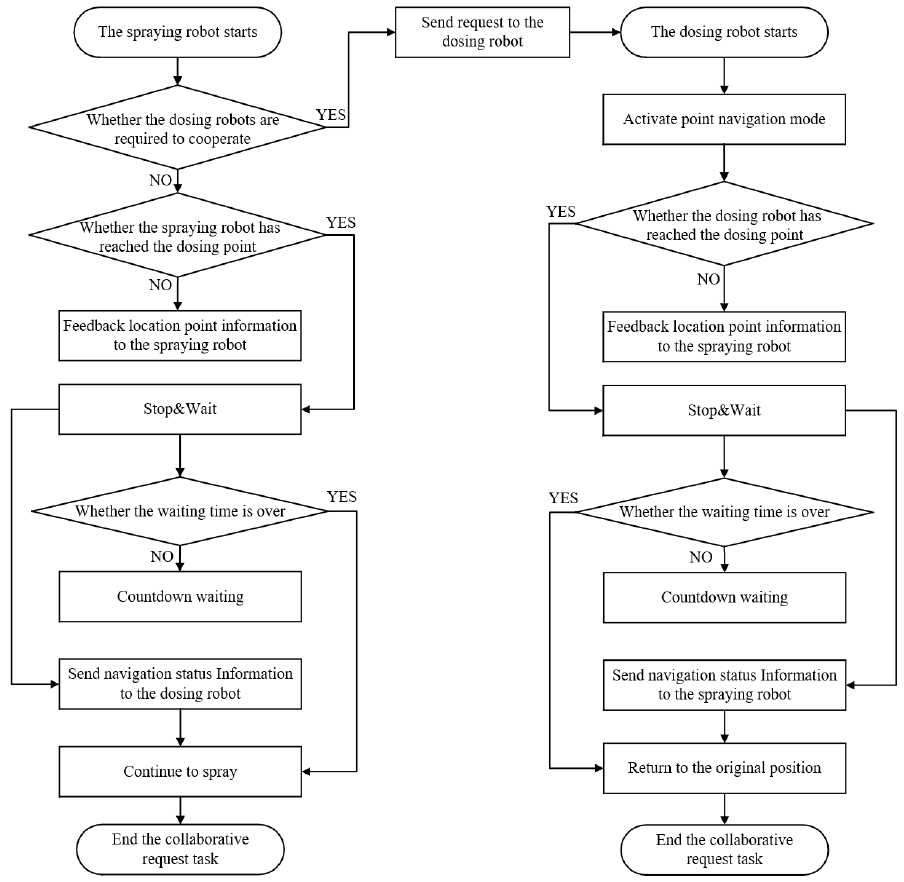
Figure 13. Spraying–dosing robot cooperative navigation strategy.